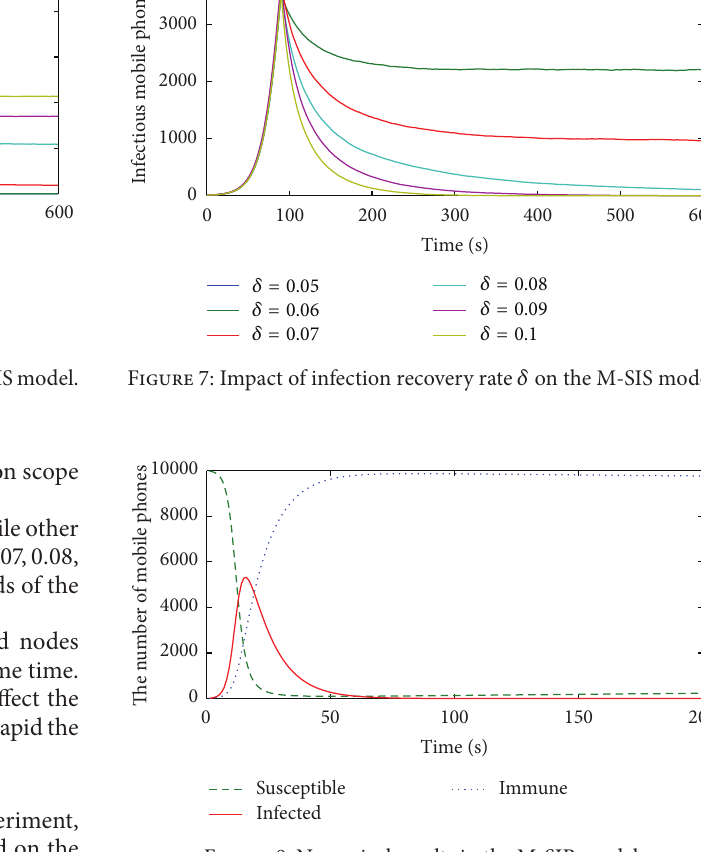
Figure 8: Numerical results in the M-SIR